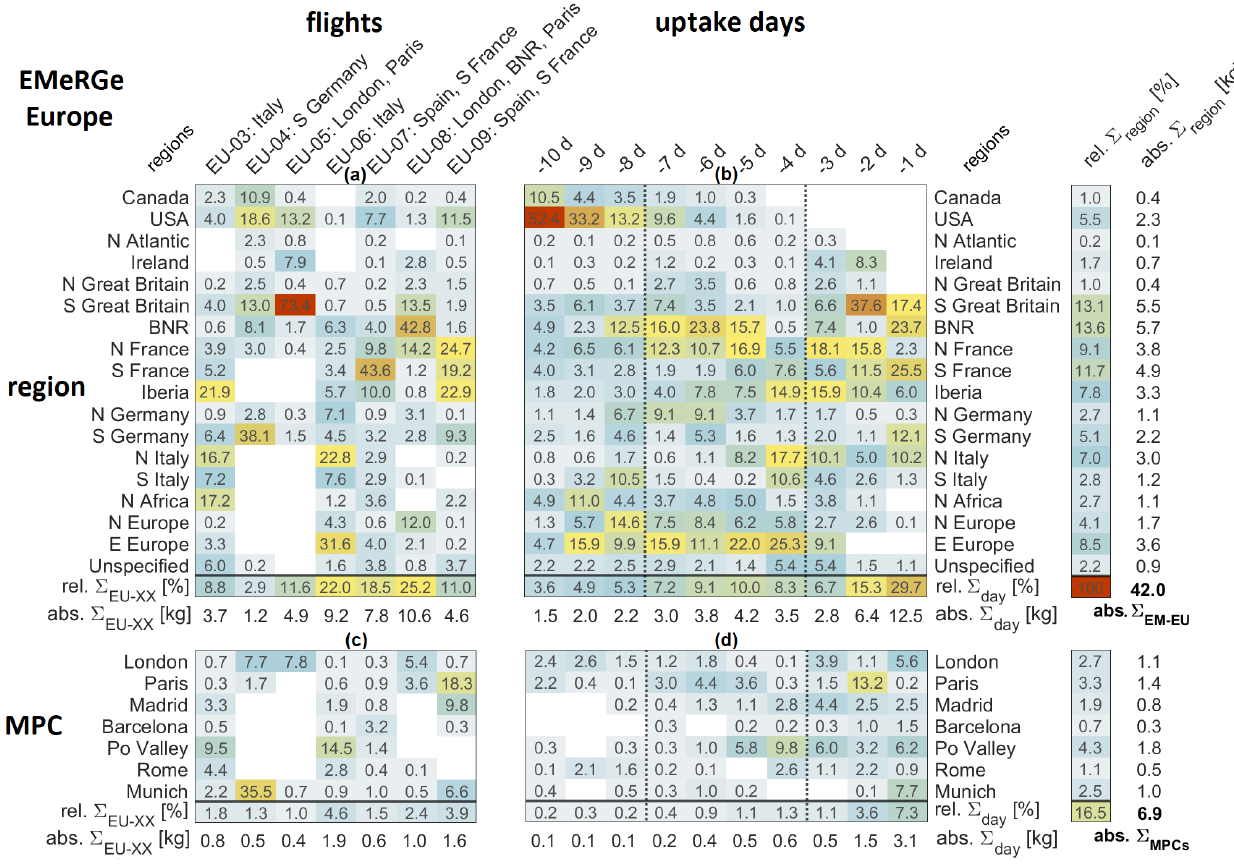
Figure 7. Absolute and relative CO contribution potentials of 17 source regions and seven MPCs (listed in Table 4) during EMeRGe- Europe. Absolute values (uncoloured rows) give the sum of contribution potentials for single flights (abs. (cid:80) EU-XX ), uptake days (abs. (cid:80) (cid:80) (cid:80) day ), as well as for source regions and MPCs (abs. region ). For EMeRGe-Europe, the total uptake sum is 42.0kg (abs. EM-EU ) and for the selected MPCs 6.9kg (abs. (cid:80) MPC ). Small deviations between absolute value sums and the total uptake sum are caused by rounding. Relative contribution potentials (colour-coded) of individual source regions are separated into contributing emission uptakes per flight (a, c) , normalised to the absolute uptake sum per flight (region EU-XX /abs. (cid:80) EU-XX ), as well as separated into contributing emissions for the 10 particular uptake days prior to sampling with HALO (b, d) , normalised to the absolute uptake sum per uptake day (region day /abs. (cid:80) day ). Relative uptake sums rel. (cid:80) x are normalised to the total uptake sum (rel. (cid:80) x = abs. (cid:80) x / (cid:80) EM-EU , with x = EU-XX, day and region). Target regions are given in the column label after flight labels. Regions are sorted by location from west (top) to east (bottom). Unspecified includes all areas outside the selected